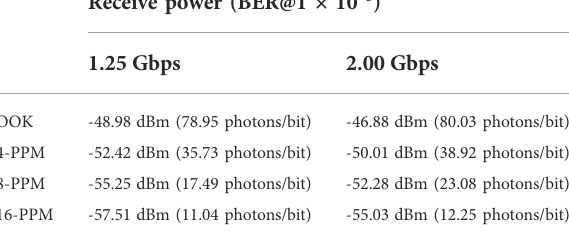
TABLE 1 Sensitivity results of the comparative